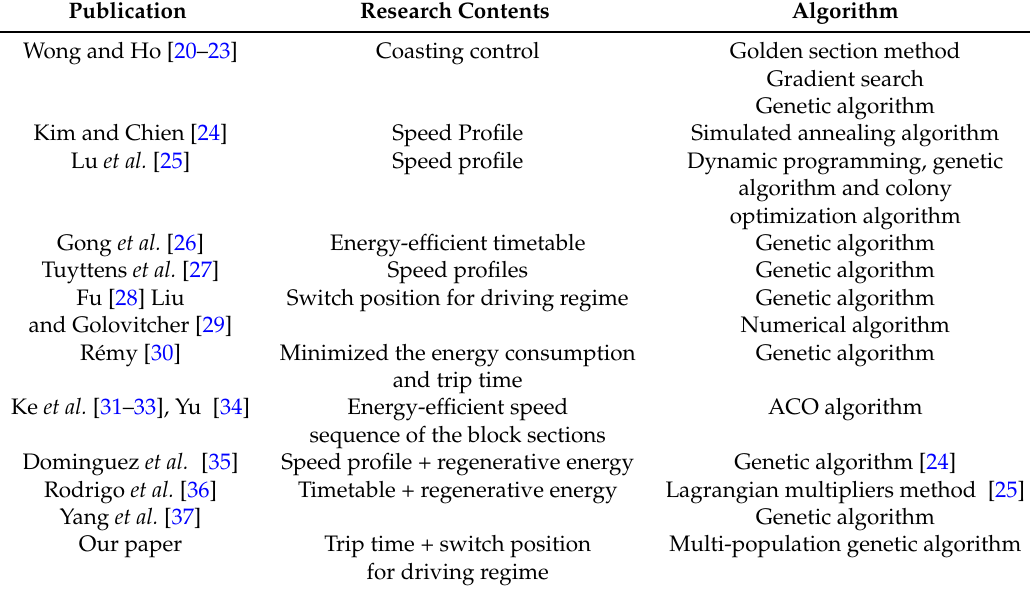
Table 1. Summary list of the studies.